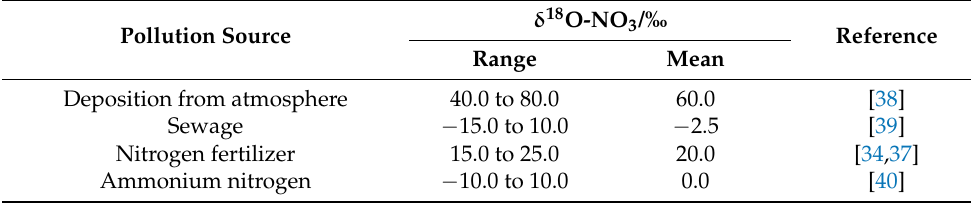
Table 2. The range of δ 18 O-NO 3 for different sources.